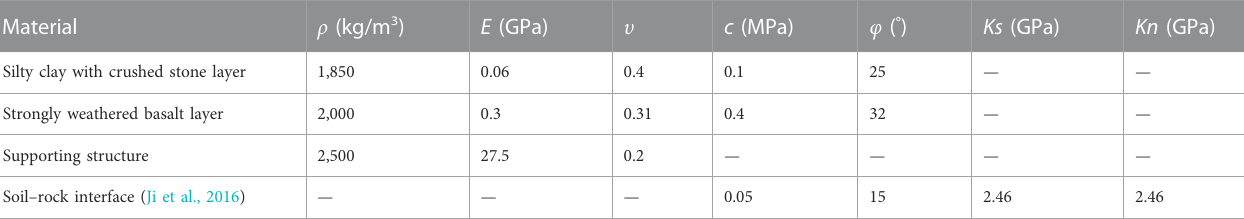
TABLE 2 Material parameters for the numerical model.